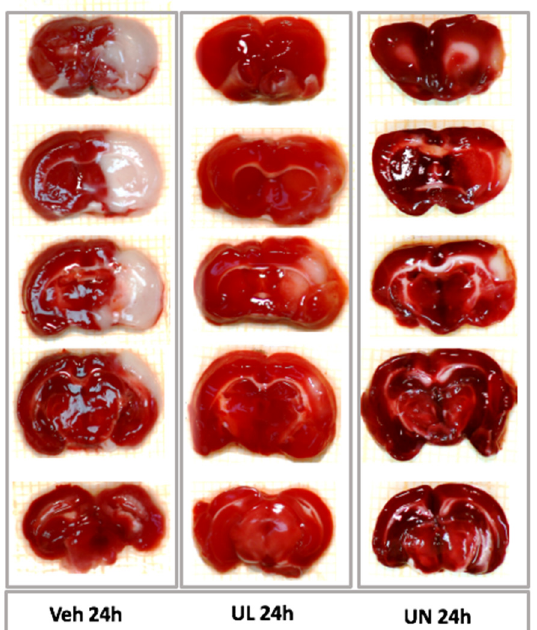
Figure 9. Sections of the brain 24 h after the middle cerebral artery occlusion. TTC staining. Viable